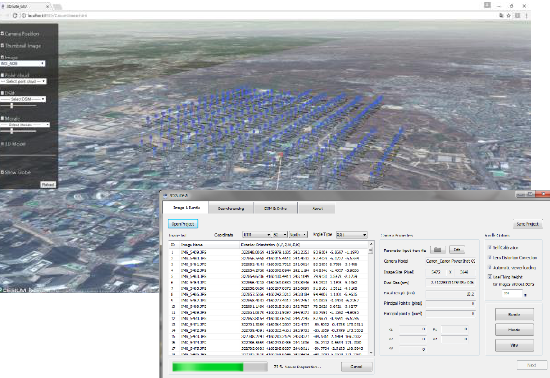
Figure 2. 3DSuite-UAV (S/W developed in